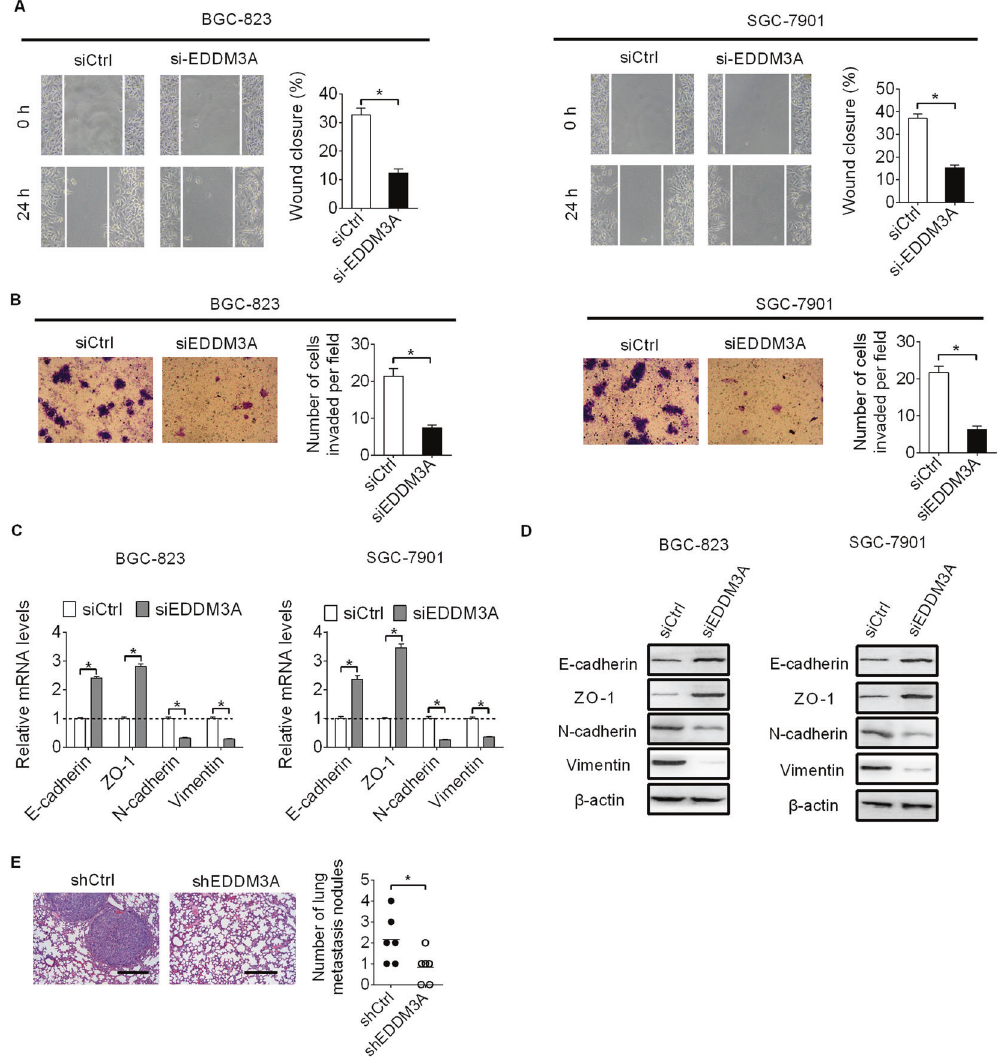
matrigel invasion assays. C , D qRT-PCR and western blot analysis for the changes of epithelial markers (E-cadherin and ZO-1) and mesenchymal markers (N-cadherin and vimentin) in BGC-823 and SGC-7901 cells, upon EDDM3A knocking down. E Metastatic nodules in the lungs from EDDM3A knockdown (shEDDM3A) or control (shCtrl) groups were analyzed using H&E staining assay. Scale bars, 100 μ